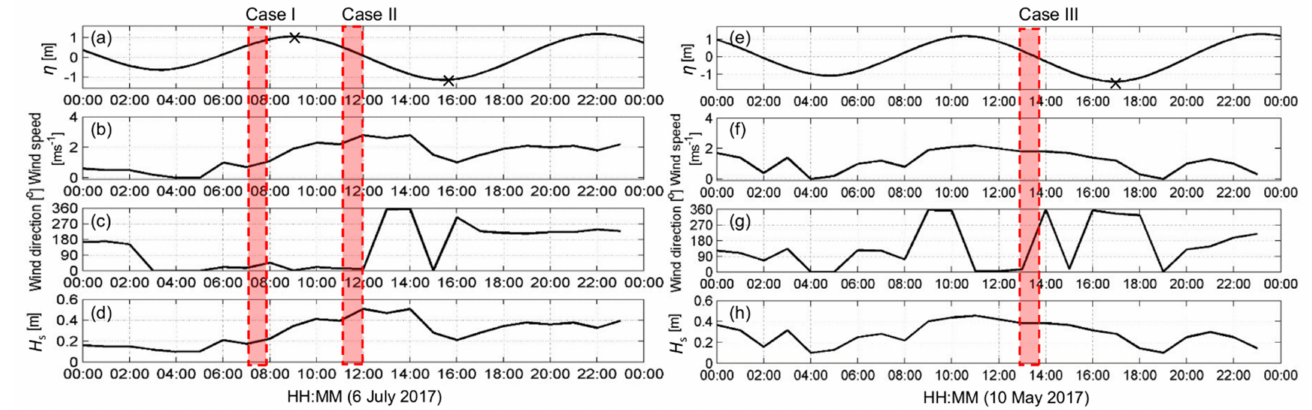
Figure 3. ( a,e ) Water level measured by Zhuwei tide gauge versus time. ( b,f ) Wind speed, ( c,g ) wind direction, and ( d,h ) significant wave height measured by Hsinchu data buoy versus time. The red shaded regions show the time period of drifter deployments for Cases I, II, and III. The x symbols in ( a,e ) represent the timing of slack transition at the Zhuwei tide gauge.